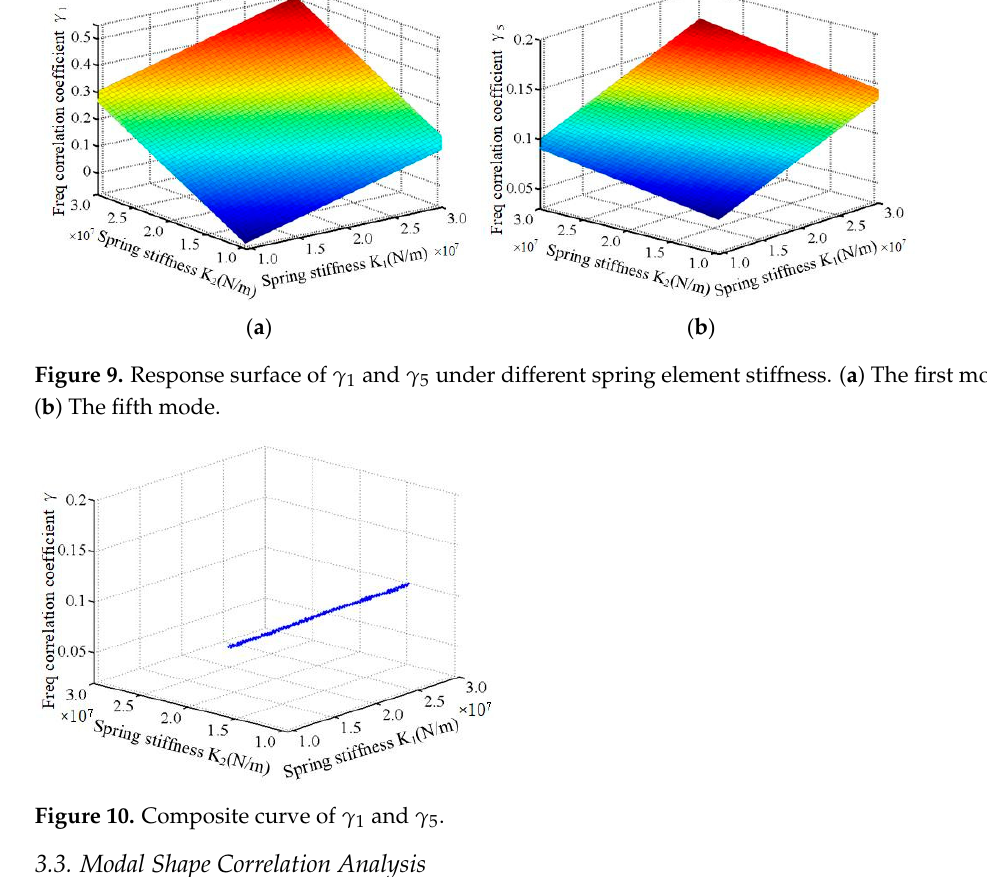
( b ) Figure 8. Variation trend of frequency difference with different spring stiffness. ( a ) The first mode. ( b ) The fifth mode. In Figure 8, the frequency difference of the first- and fifth-order modes increases with the increase in the stiffness of the spring unit and both of them have a linear trend. The polynomial surface function is used to regression fit the first- and fifth-order fre- quency correlation coefficients. The higher order of the K term of the polynomial surface function is 1 due to a linear trend between the frequency difference and the spring unit stiffness. The regression models for the first frequency correlation coefficient γ 1 and the fifth frequency correlation coefficient γ 5 are shown in Equations (4) and (5), respectively. 9